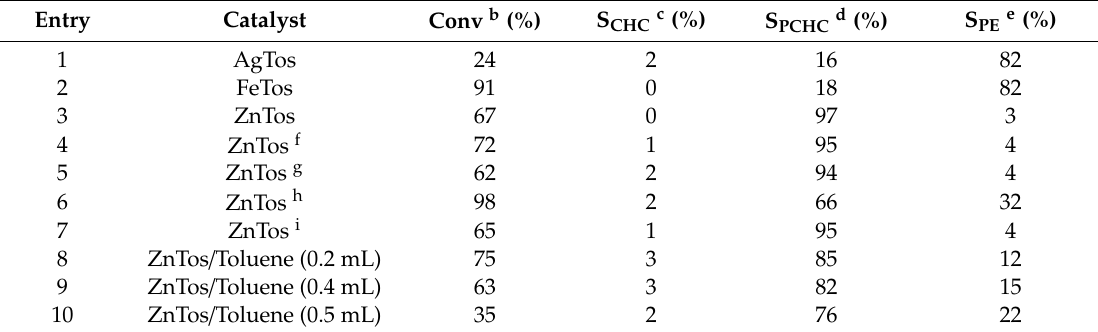
Table 4. Catalytic studies performed with metal tosylates complexes a .